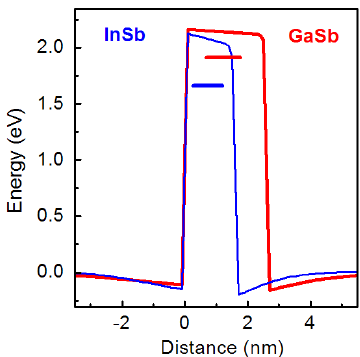
Figure 12. Valence band top diagrams and energy levels calculated for GaSb/AlP (red lines) and InSb/AlP (blue lines) SAQDs with critical sizes.